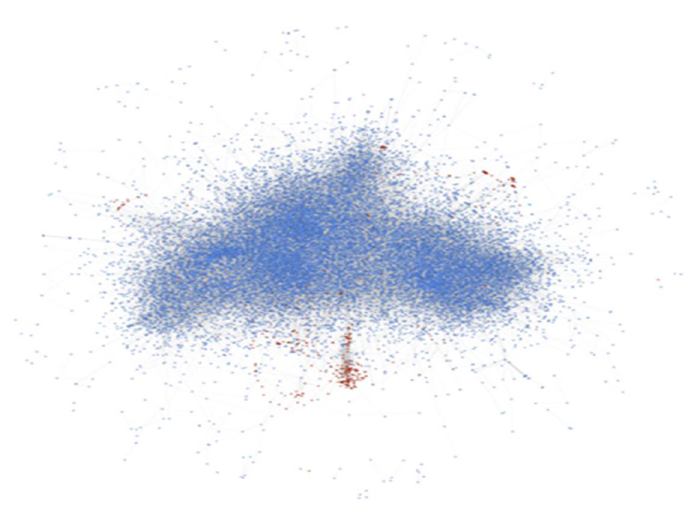
Figure 4. “Article-patent” dual-layer knowledge-flow network model.